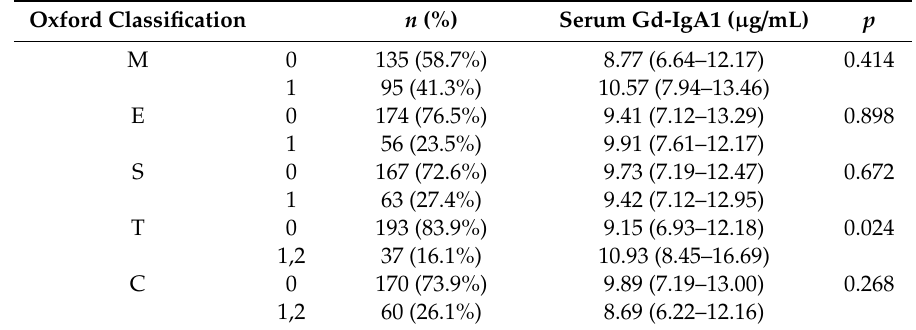
Table 2. Serum Gd-IgA1 levels according to pathologic findings based on the Oxford classification (MEST-C).